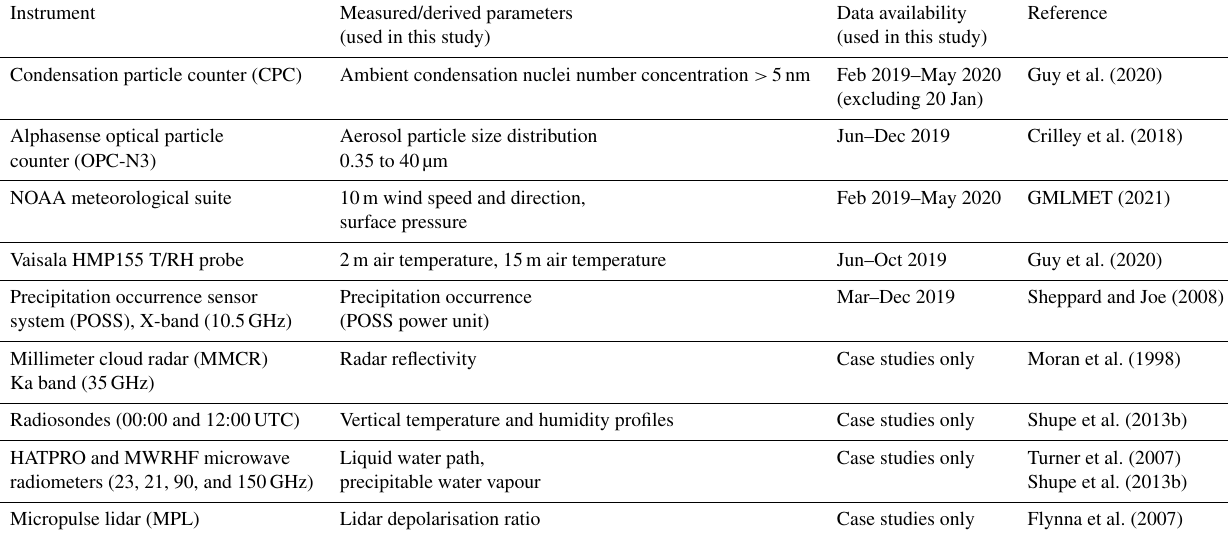
Table 1. Measurements used in this study; references provide additional instrument information and methodologies for derived